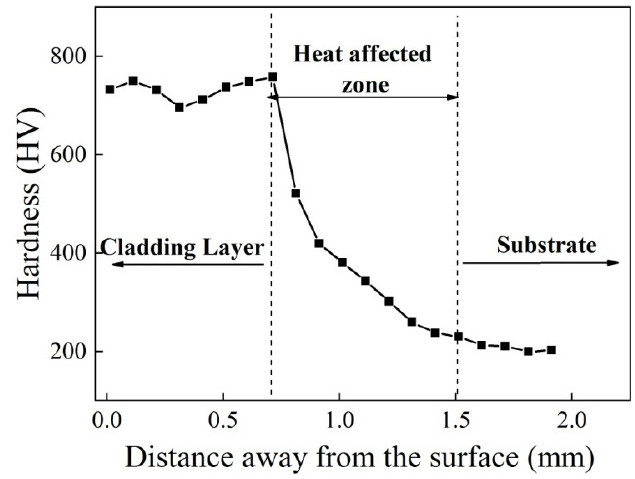
Figure 6. Hardness distribution of the Co-based alloy cladding layer.